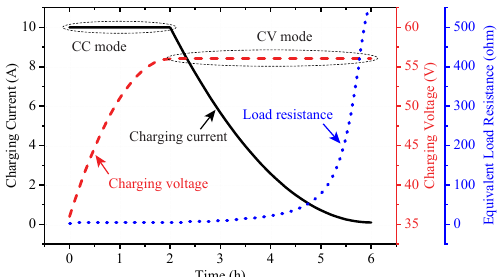
Figure 1. A classical constant current/constant voltage (CC/CV)-based charging process